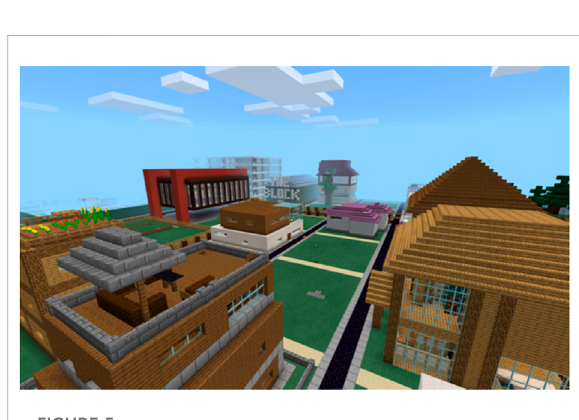
FIGURE 5 The Japanese Village created by students in